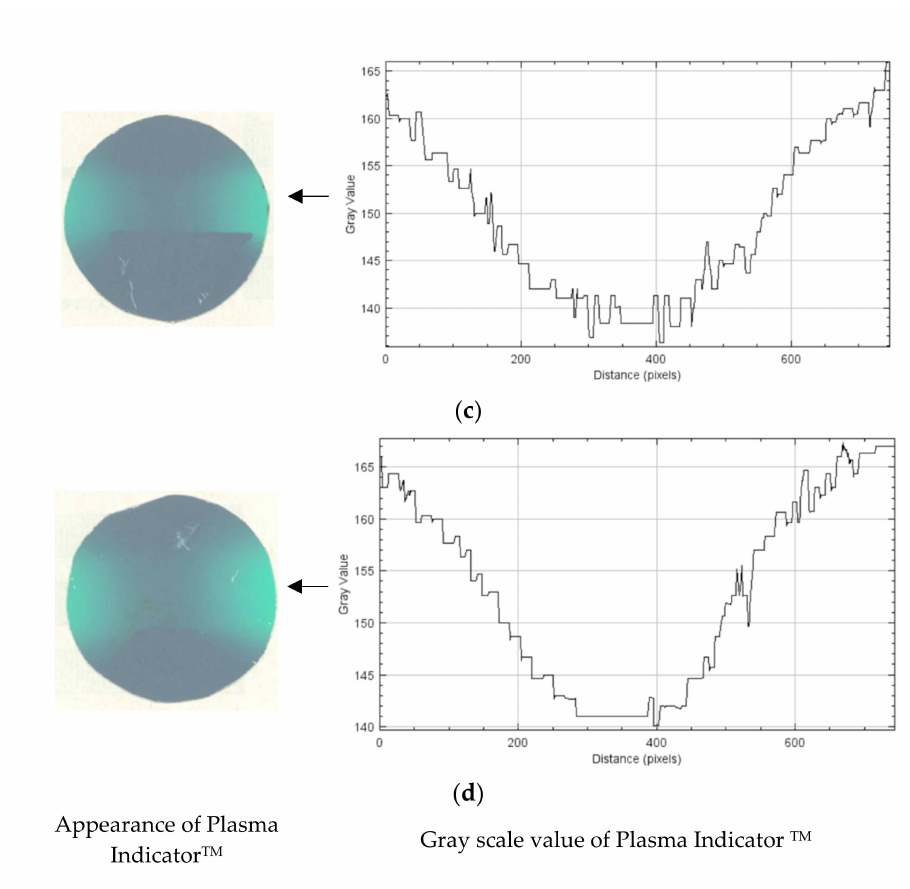
Figure 13. Color change of Plasma Indicator TM and gray scale value for each pulse number. ( a ) 500 shots;